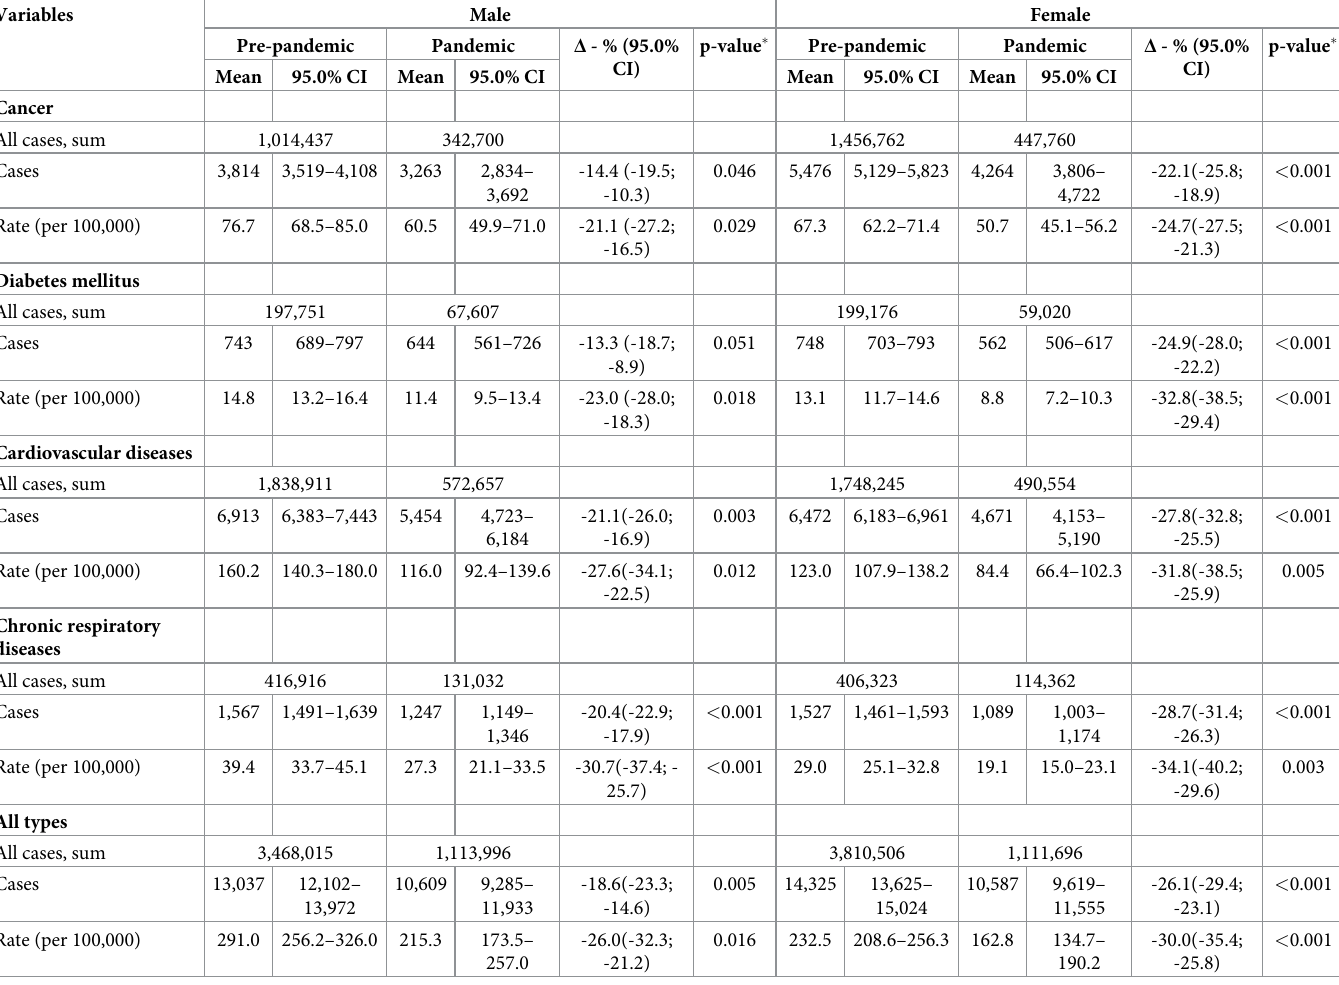
Table 2. Hospital admissions for chronic non-communicable diseases (NCDs) in Brazil before and after the onset of the coronavirus disease pandemic according to the type of NCD and sex.